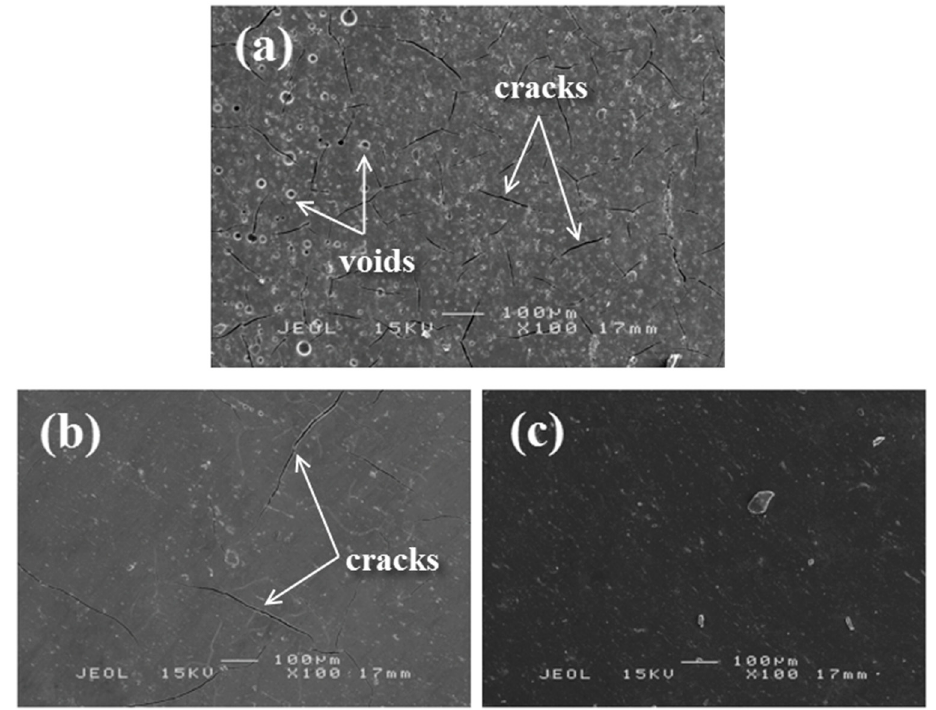
Figure 13. SEM images of ( a ) S17—Brittle coating, exhibited lowest flexural strength; ( b ) S14—Brittle coating, exhibited highest flexural strength, and ( c ) S13—Ductile coating.